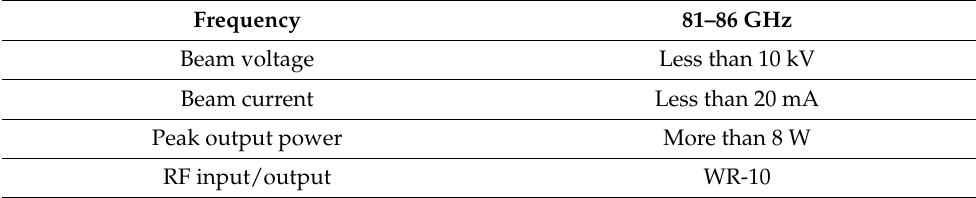
Table 1. Operational parameters.